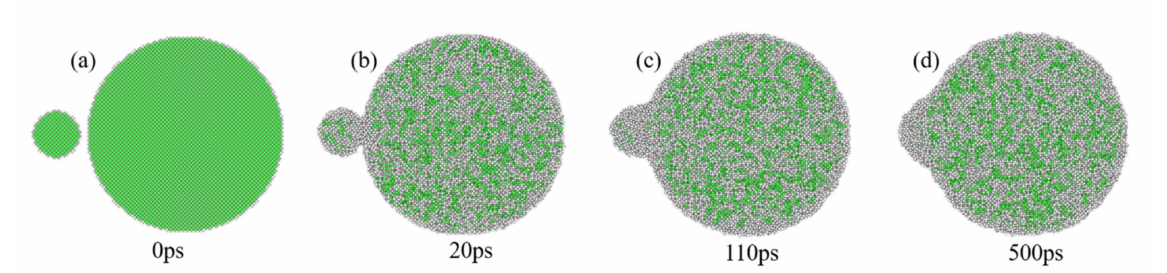
Figure 12. The structural evolution of UPs-520 during the sintering process corresponding to the sintering time when sintered at 1000 K when ( a ) 0 ps, ( b ) 20 ps, ( c ) 110 ps and ( d ) 500 ps. The color bar is the same as that in Figure 5.